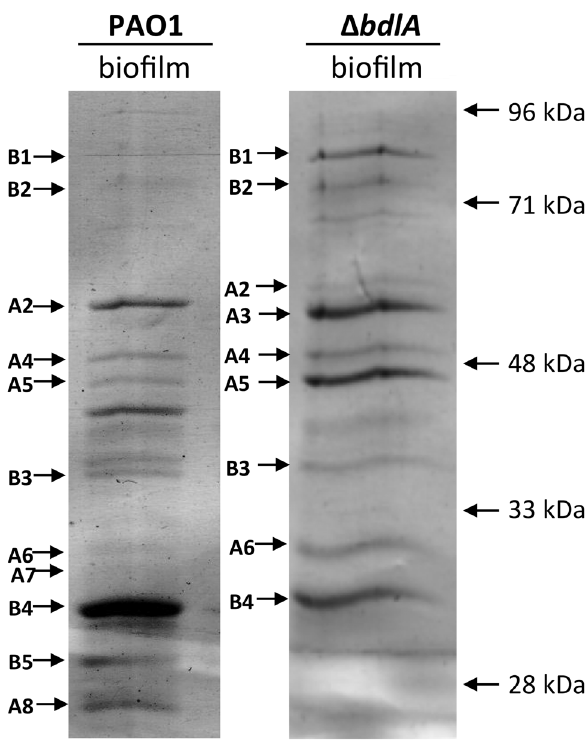
Figure 3. Analysis of proteins present in supernatants of P. aeruginosa PAO1 and D bdlA biofilms. A total of 10 m g supernatant protein obtained from P. aeruginosa PAO1 and D bdlA biofilms was loaded per lane. Protein bands indicated by a letter and arrow were selected and subsequently identified by LC-MS/MS (see also Table 1). Experiments were repeated in triplicate and a representative SDS-gel image is shown. Molecular masses are indicated on the right (in kDa).